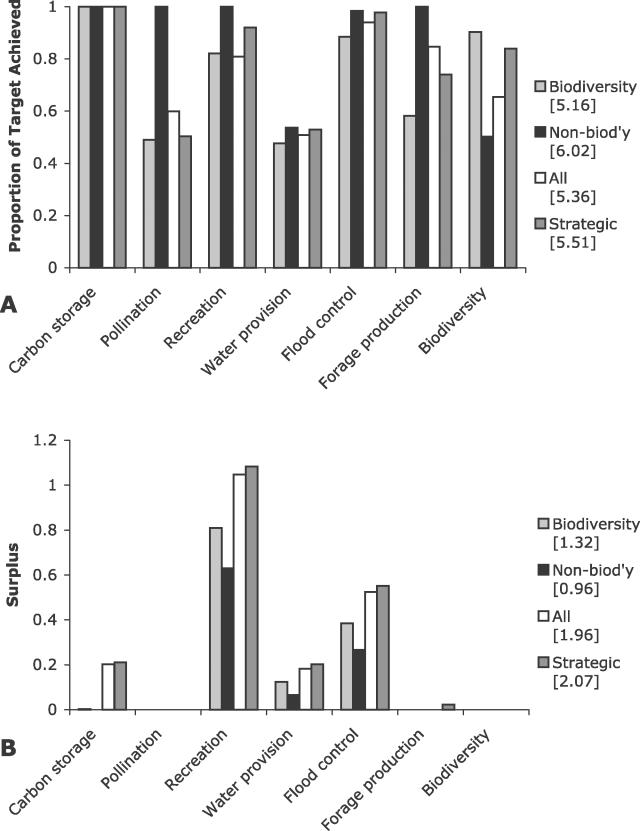
The Achievement of Alternative Strategies at Meeting Conservation TargetsTarget achievement is represented as the proportions of the seven targets achieved by four different conservation scenarios: Biodiversity (only biodiversity); Non-biodiversity (all except biodiversity); All; and Strategic (all but forage production and pollination: biodiversity, carbon storage, flood control, recreation, and water storage).(A) The average target achieved (achieved feature/target) across stratification units weighted by amount of target, capped at 1 where targets were exceeded.(B) The average amount by which targets were exceeded, weighted by target. The total target achievements and surpluses, summed across ecosystem services, appear enclosed in square brackets in the legend. This unweighted total underrepresents the contribution of biodiversity (which alone had hundreds of features, compared with one for each ecosystem service per stratification unit) to the planning process.